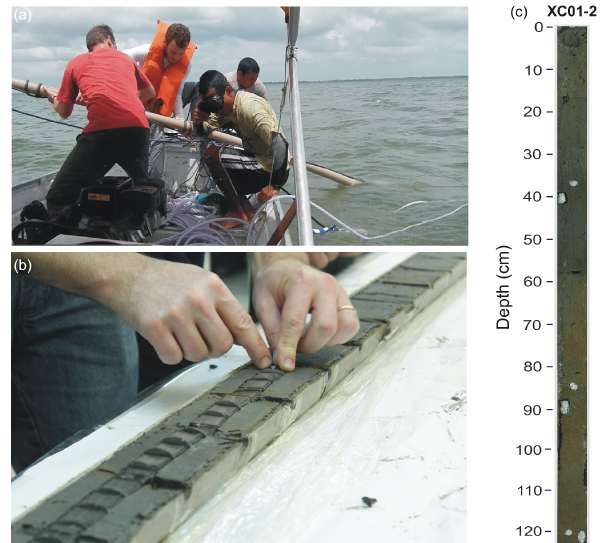
Figure 5. (a) Retrieving of the XC03 core during November of 2014. (b) Sampling of the XC05 core (470cm) for magnetic anal- ysis. This core is composed of homogenous organic muddy sed- iments. (c) Sediment column of the XC01-2 core, with a bottom sand layer covered by dark gray to brown